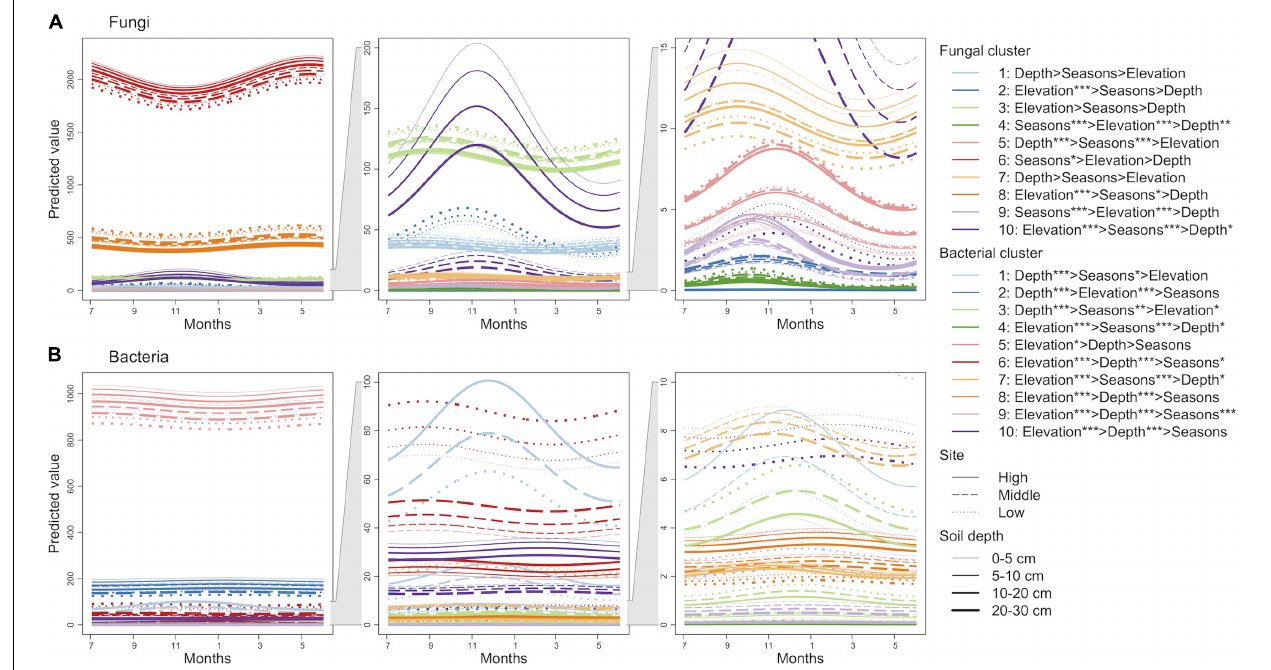
FIGURE 2 | Seasonal dynamics of the predicted sequence counts of soil fungi (A) and bacteria (B) based on finite mixtures of negative binomial regression models. The time series starts on July 3, 2016. The clusters are colored differently. Solid, dashed, and dotted lines represent high, middle, and low elevation sites, respectively. Width of lines increases from shallow to deep soil depth. The importance of seasons (cosine and sine function with 1-year periodicity; Sc and Ss ), elevation, and soil depth are denoted (e.g., Elevation > Depth shows that elevation has higher relative importance than soil depth). ∗∗∗ P < 0.001, ∗∗ P < 0.01, and ∗ P < 0.05.